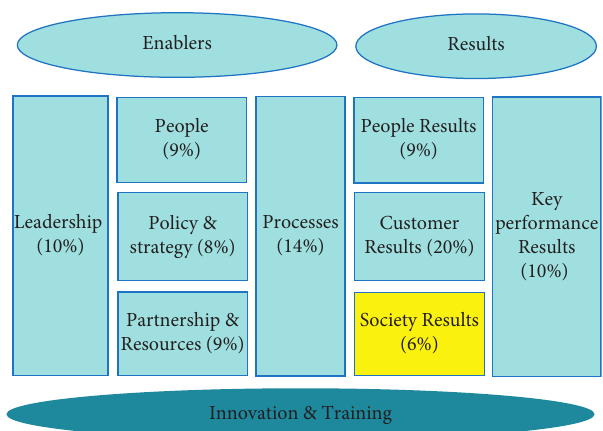
Figure 3: EFQM excellence